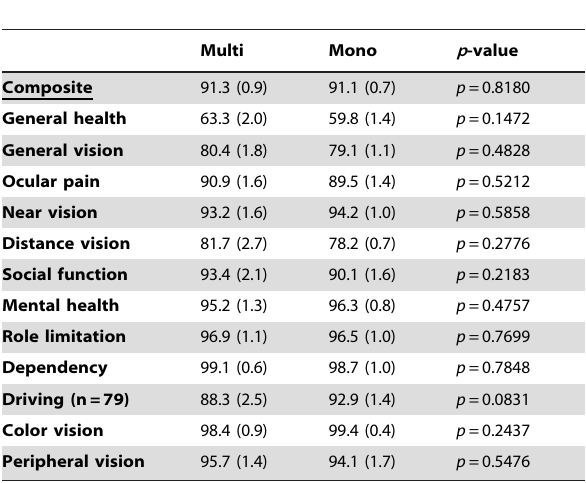
Table 2. Postoperative scores of the NEI VFQ-25.